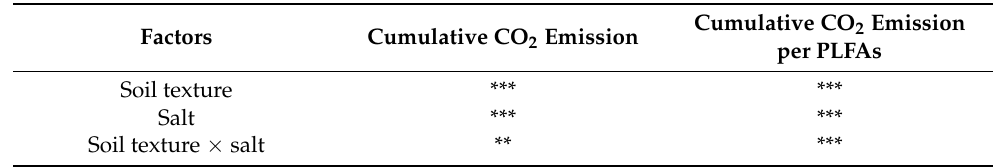
Table 3. Main and interaction effects of soil texture and salinity on cumulative CO 2 emissions and qCO 2 .